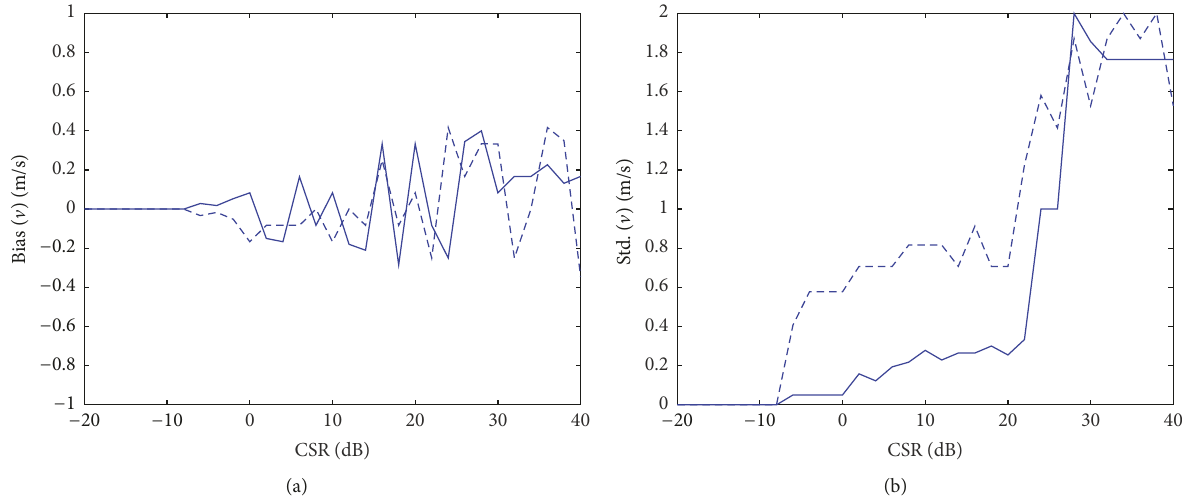
Figure 3: Bias (a) and standard deviation (b) of velocity estimates for the 4-PRT (solid line) and 2-PRT (dashed line) with SNR = 40dB using the PTDM.